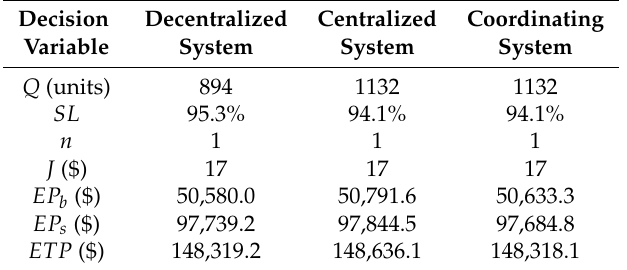
Table 4. Output data for numerical problem 1, in case of reliable Seller.